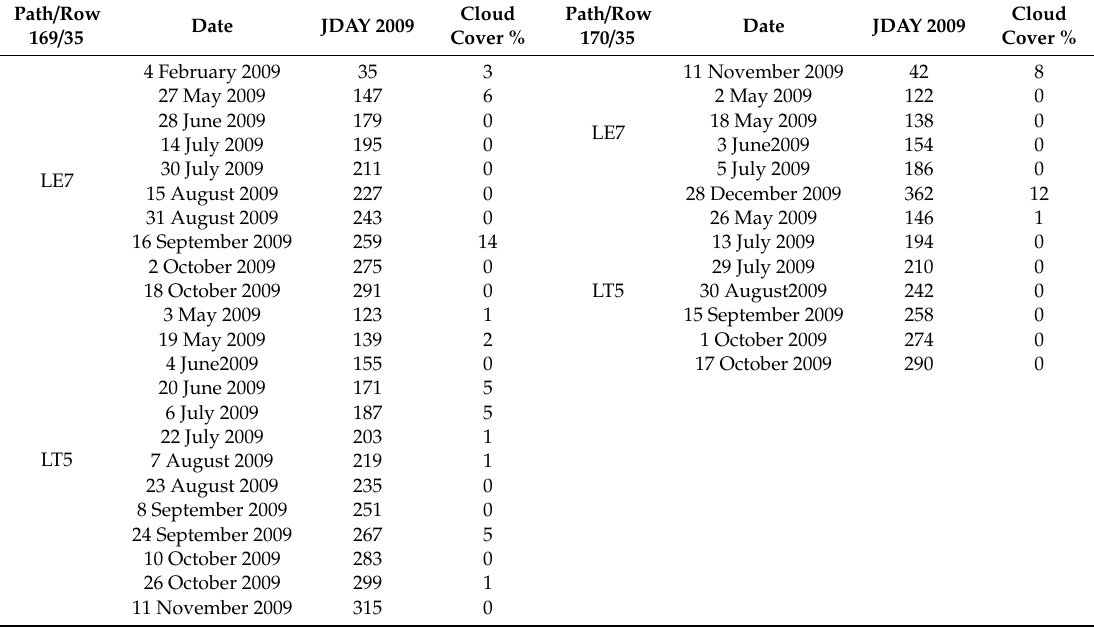
Table 1. Landsat images used to estimate T w in the Tigris River at Mosul.